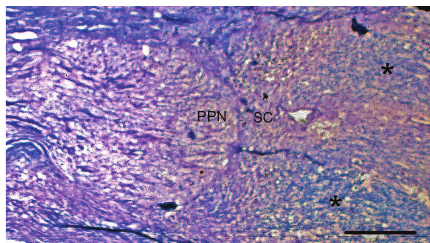
Figure 9: Spinal cord transplant interface. Photomicrography of a specimenfromthePPN+BMSCsgroupinwhichexcellentadhesion between the transplanted nerve (PPN) and the distal spinal cord (SC) stump can be observed. The spinal cord shows a good level of myelination (*). Kluver-Barrera staining. Calibration bar 500 𝜇